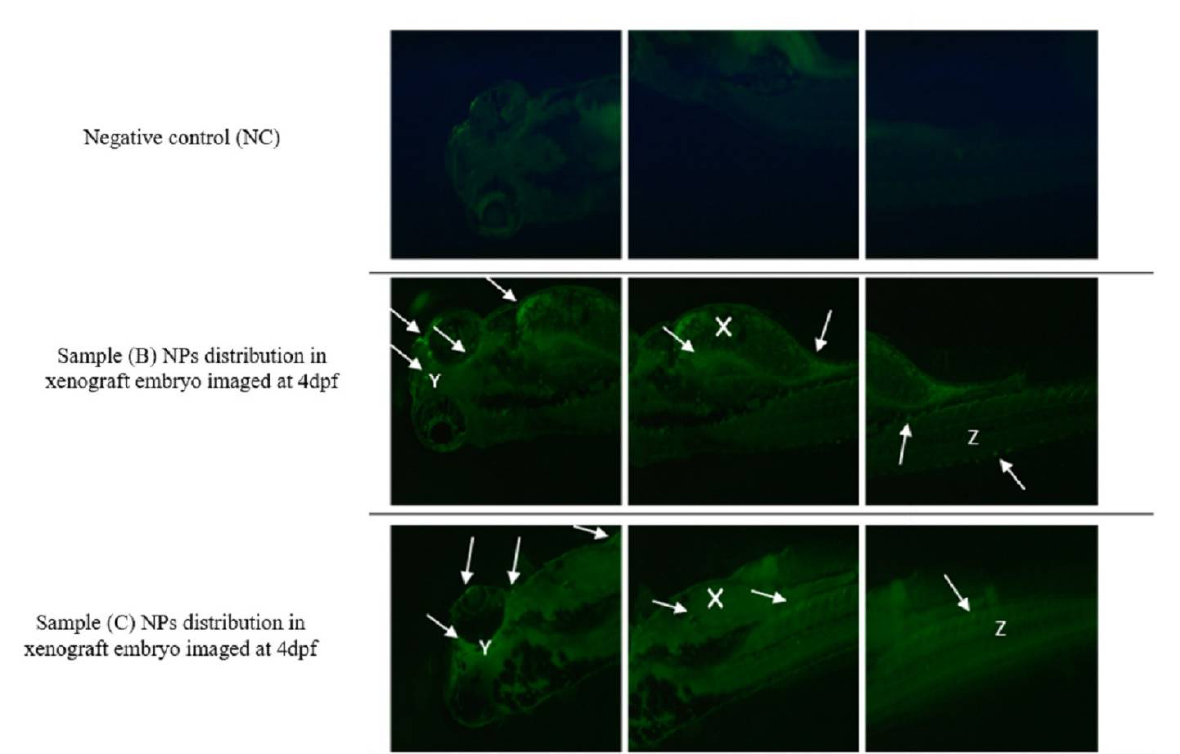
Figure 11. Loaded PLGA-PEG-PLGA NPs uptake. Representative fluorescence images of zebrafish screening at 4 dpf using fluorescent microscopy and investigation of fluorescent PLGA-PEG-PLGA NPs distribution (white solid arrows) throughout the animal body (Y—eyes; X—yolk sac; Z—tail) using GFP fluorescence filter. Original magnification 100×.